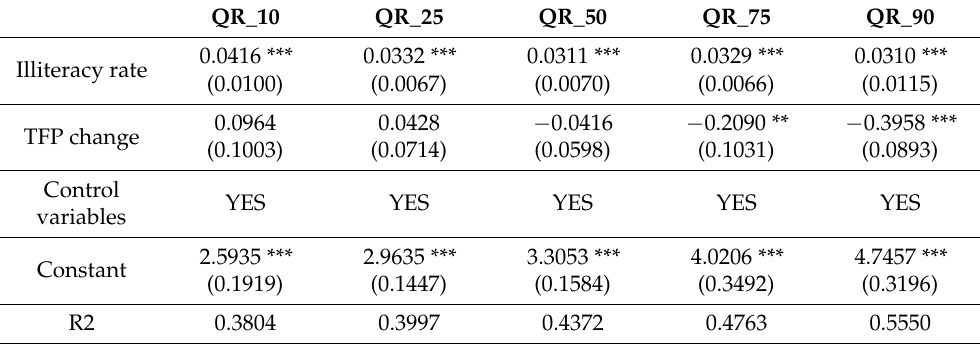
Table 8. Estimate results of quantile